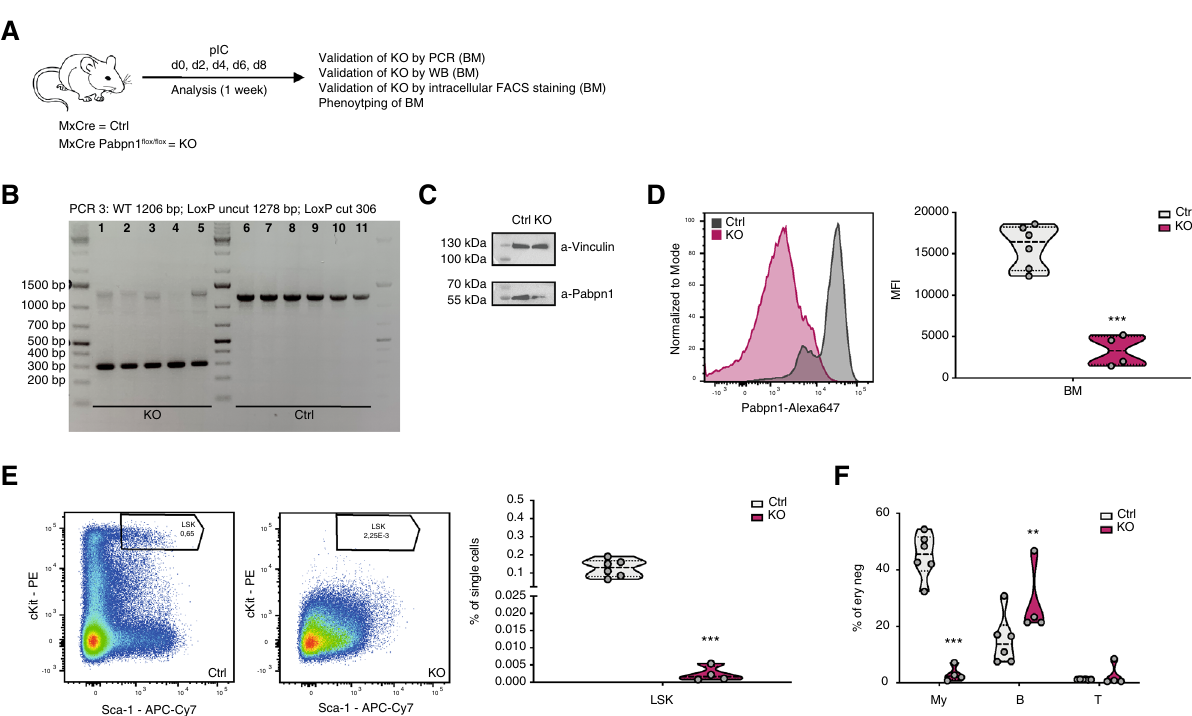
Figure 2. Generation of MxCre Pabpn1 flox/flox mice and validation of Pabpn1 KO. ( A ) Workflow of MxCre Pabpn1 flox/flox treatment and analysis approach. ( B ) Gel images showing analysis of DNA recombination in MxCre Pabpn1 flox/flox and MxCre control mice. ( C ) KO validation by western blot analysis using ery-lysed total BM cells. Images were cropped, see Supplementary Fig. 2A for blots. ( D ) KO validation by intracellular flow cytometry analysis using ery-lysed total BM cells. ( E ) Flow cytometry-based analysis of the HSPC containing LSK population in the BM. ( F ) Flow cytometry-based analysis of hematopoietic lineages in the BM. For all experiments: Representative flow cytometry plots are shown. n = 4–6. n indicates number of biological replicates; 1 independent experiment; mean + SD is shown; unpaired Student’s t test ( D,E ); Two-way ANOVA ( F ); *p < 0.05; **p < 0.01; ***p < 0.001. LSK (Lin− Sca-1+ cKit+), T cells (T) (CD71− Ter119− GR1− CD11b− CD4/8+ B220−), B cells (B) (CD71− Ter119− GR1− CD11b− CD4/8− B220+), myeloid cells (My) (CD71− Ter119− GR1+ CD11b+). Drawings ( A ) were created using Adobe Illustrator 2022